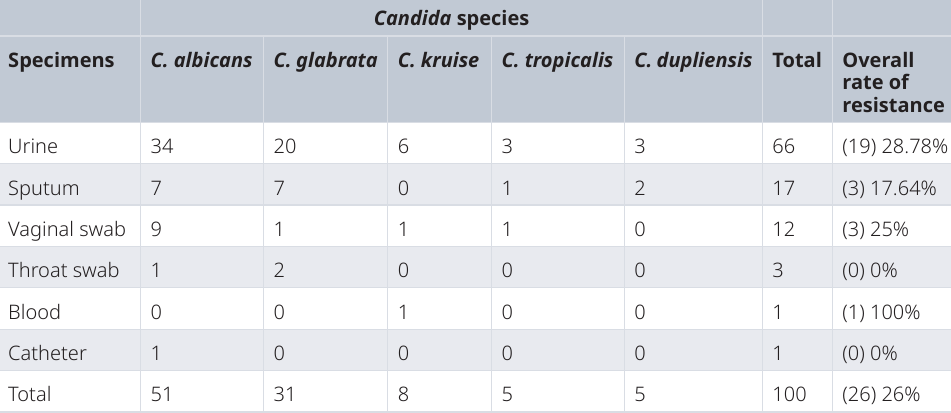
Table 1. Different site of isolations in relation to frequency of each Candida species